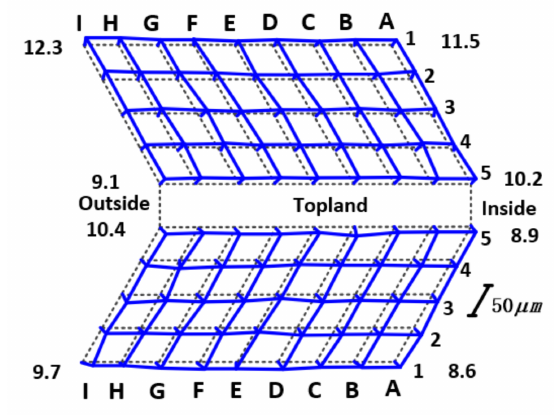
Figure 12. Flank topology of the face gear after finishing.